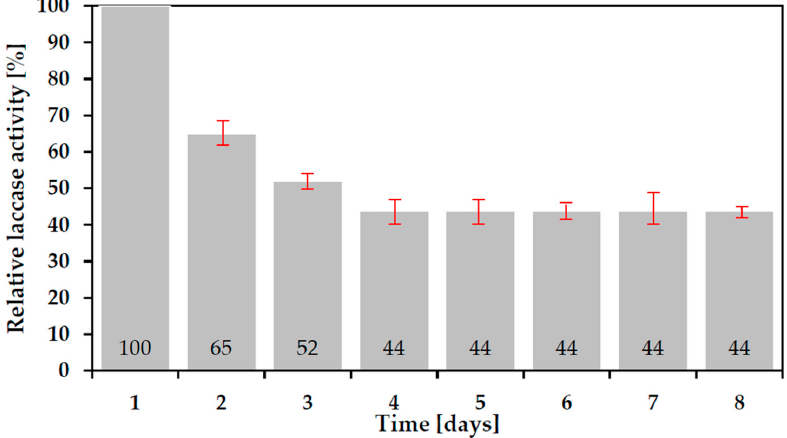
Figure 8. Durability of Corona SPP laccase coatings deposited on glass slide (U = 3 kV, VHe = 10 L/min, sample: rutin solution at concentration 0.0001 mol/dm 3 ).